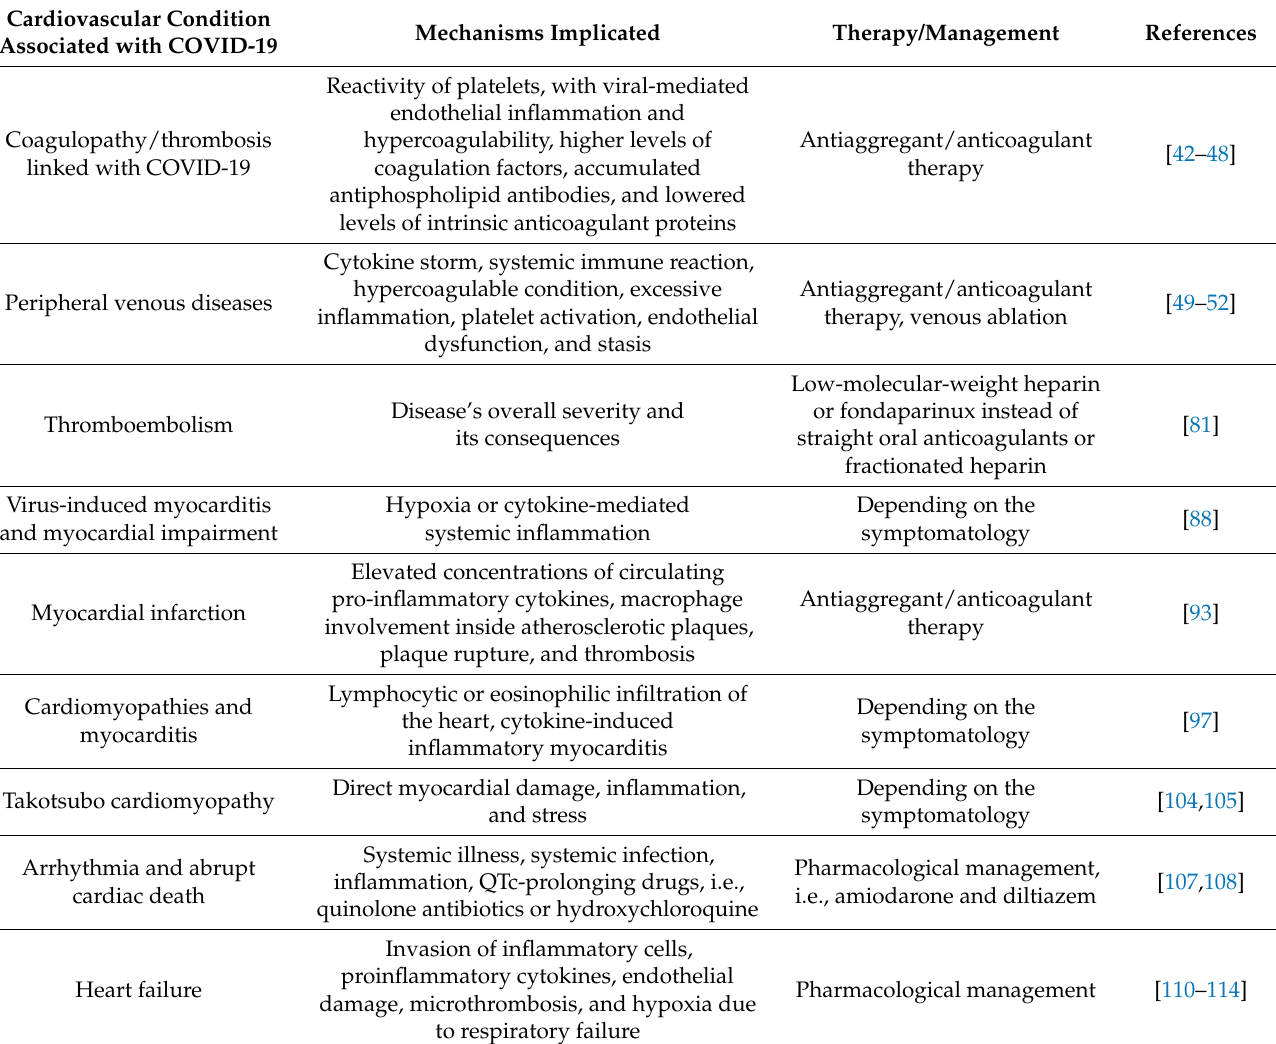
Table 1. Different cardiovascular conditions associated with COVID-19, mechanisms implicated, and therapy/management